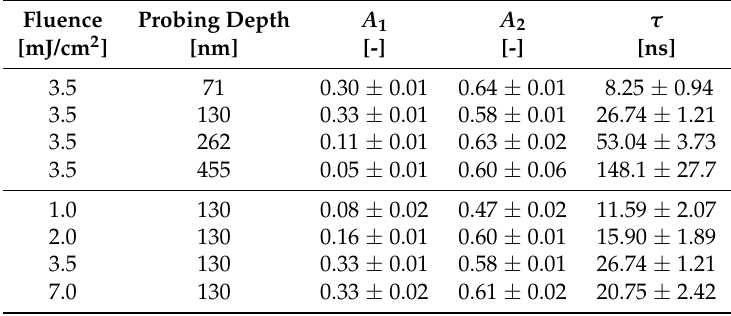
Table 1. Optimal fit parameters for Equation (1), for different experimental